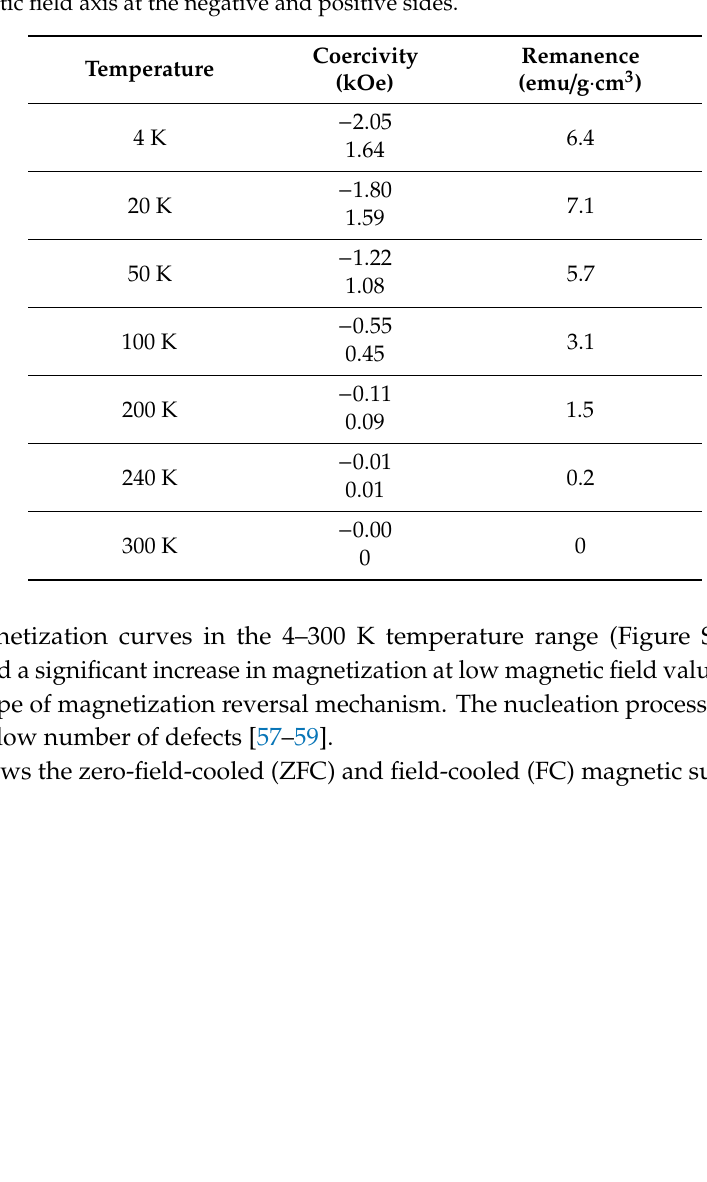
Table 2. Coercivity and remanence values determined from magnetization vs. magnetic field curves at di ff erent temperatures. The two coercivity values given correspond to the hysteresis loop intersection with a magnetic field axis at the negative and positive